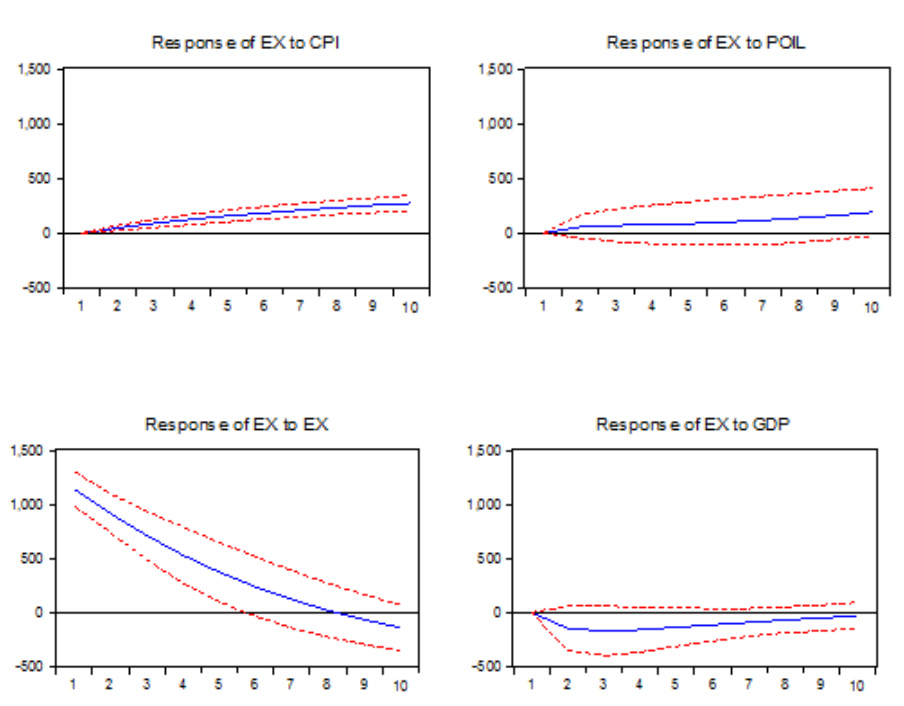
Figure 4. Impulse response functions when there is a shock with the magnitude of one standard deviation